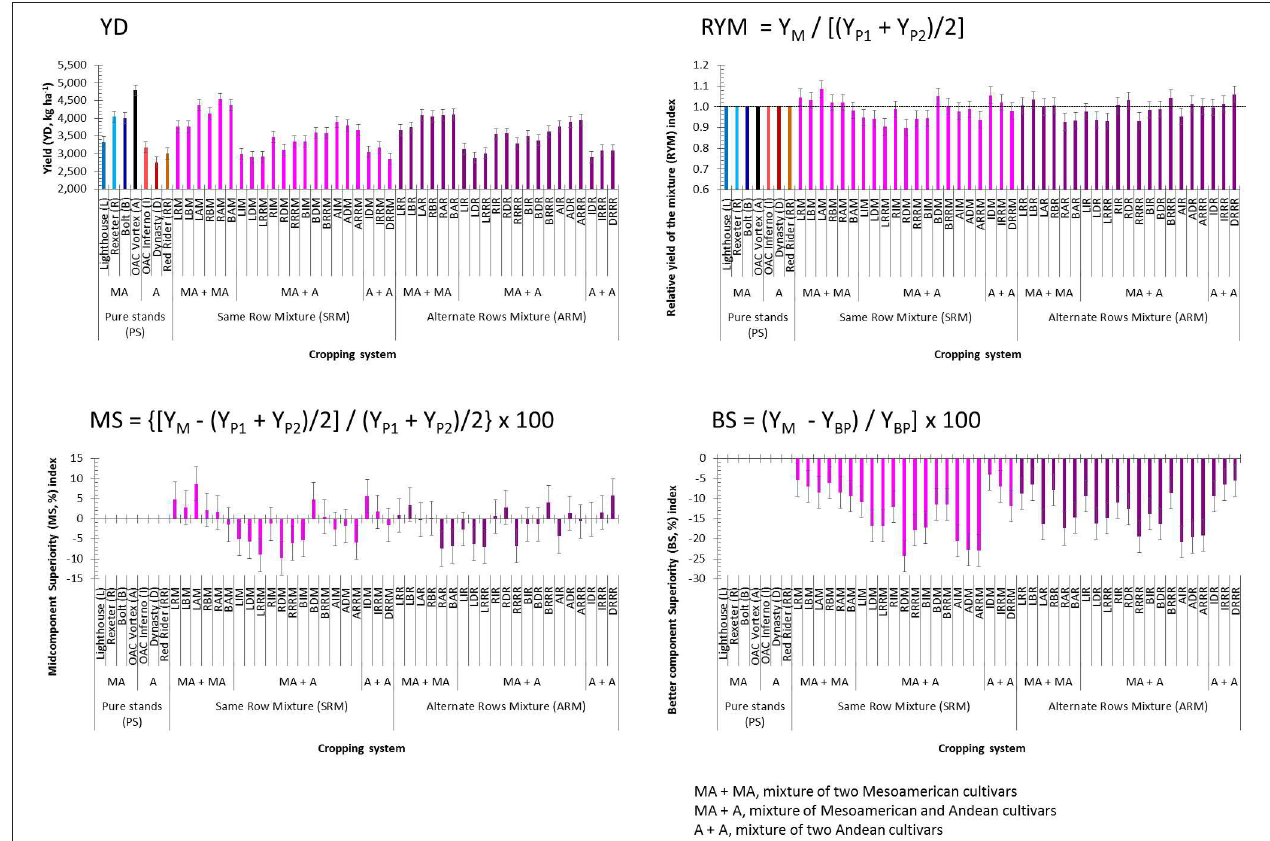
FIGURE 3 | Trait means and standard errors of the seven common bean genotypes evaluated in pure stands and binary mixtures [same row mixture (SRM) and alternate rows mixture (ARM)] averaged over three Ontario environments/locations in 2018. Traits: yield (YD, kg ha − 1 ) and three yield-based indices [relative yield of the mixture (RYM), midcomponent superiority (MS) and better component superiority (BS)]. In each histogram, cropping system [seven cultivars in pure stands, 21 SRMs (same row mixtures) and 21 ARMs (alternate row mixtures)] and gene pool [MA, Mesoamerican; A, Andean; MA + MA, mixture of two Mesoamerican cultivars; MA